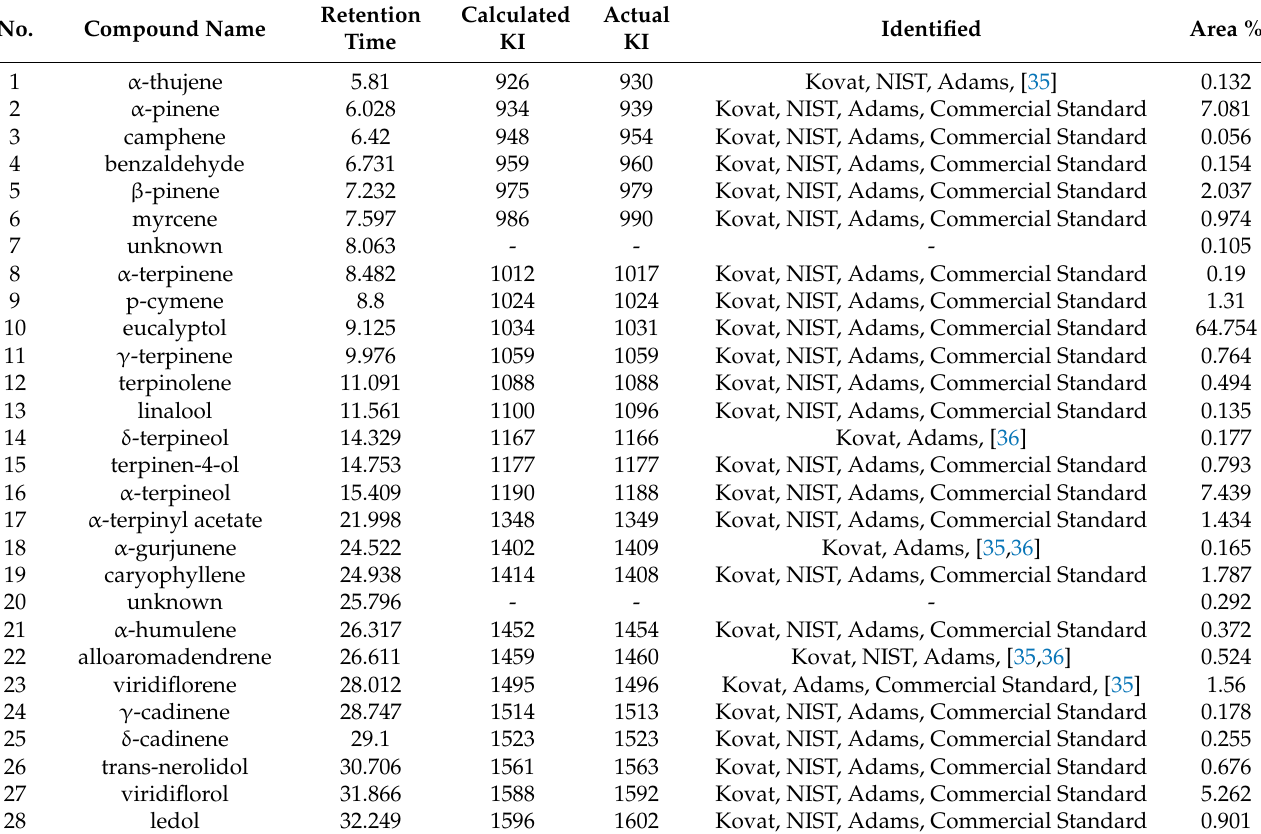
Table 5. Melaleuca quinquenervia essential oil (EO) constituents identified via GC–MS–FID